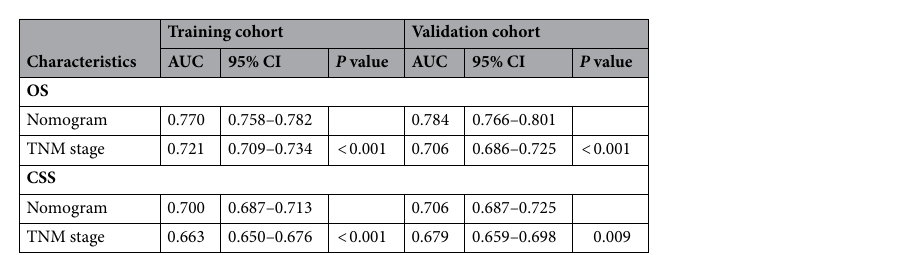
Table 4. Comparison of area under the curve (AUC) between the nomogram and TNM stage in gastric cardia cancer (GCC) patients . AUC area under the curve, CI confidence interval.